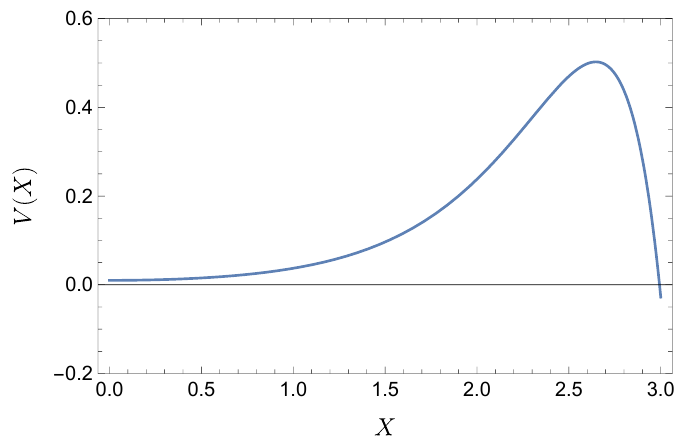
/k = 1 . The potential has an unstable 5